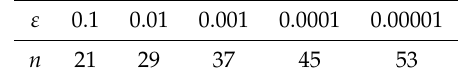
Table 21. Number n of iterations needed by the a priori estimate if started with ( 0.2,2.8 )